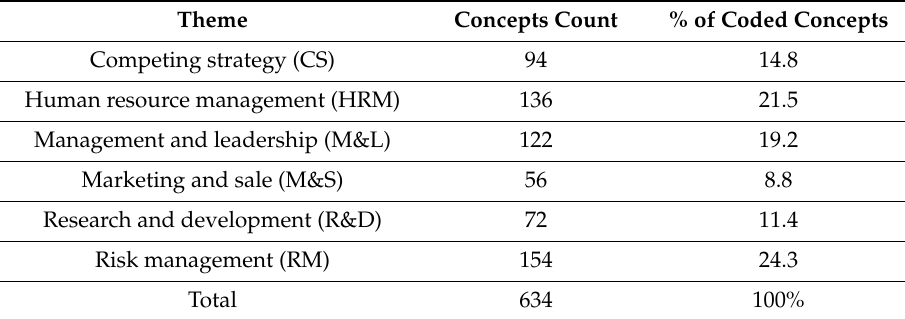
Table 1. The first level of thematic